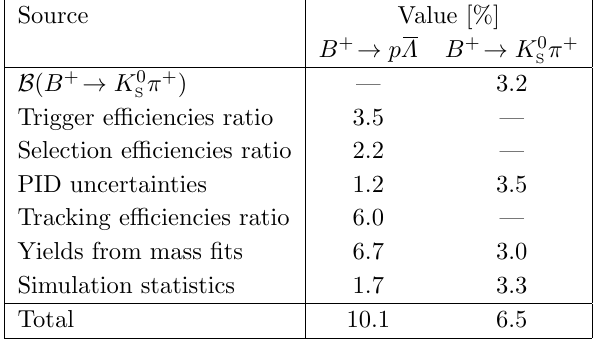
Table 1 . Summary of systematic uncertainties relative to the measured B + ! p(cid:3) branching fraction. The contributions are split into those that come from the signal decay and those that come from the normalisation decay. The total corresponds to the sum of all contributions added in